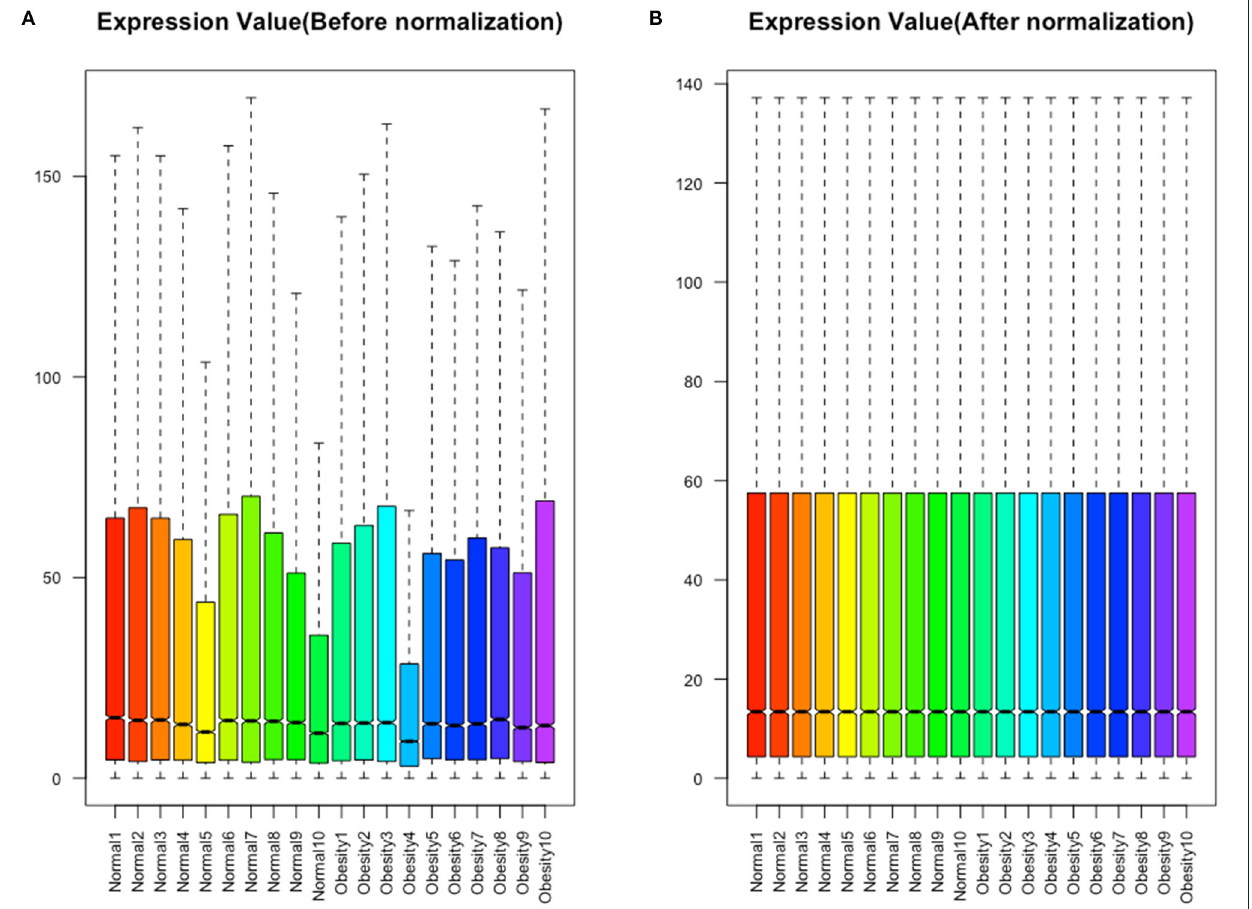
FIGURE 1 | Normalization of all samples. ( A ) Before normalization. ( B ) After